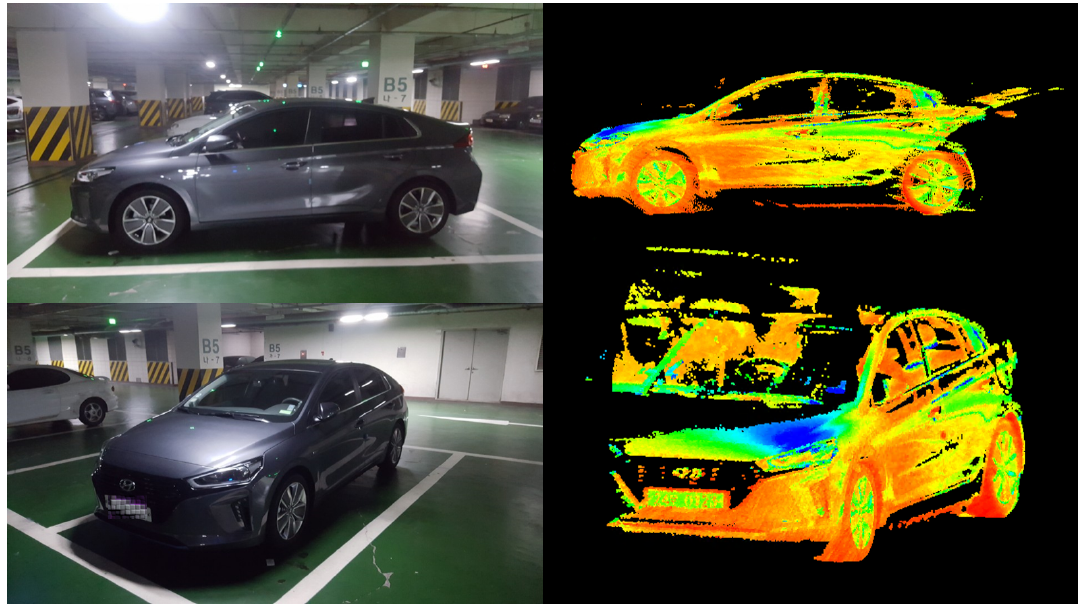
Figure 6. Examples of extended noise points reflected by the car surface.